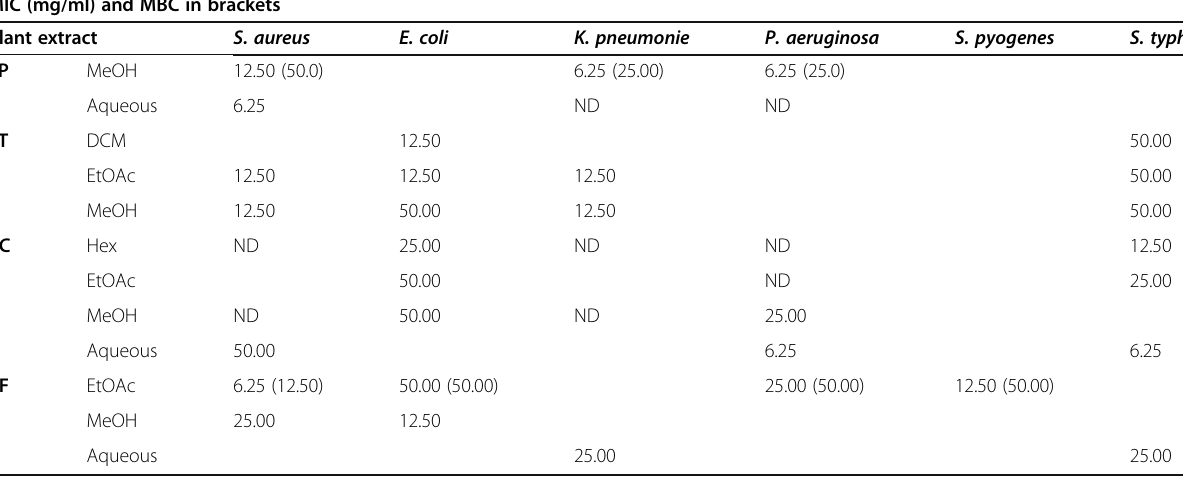
Table 2 Minimum inhibitory concentration (MIC) and minimum bactericidal concentration (MBC) of the plant extracts against tested bacterial strains MIC (mg/ml) and MBC in brackets Plant